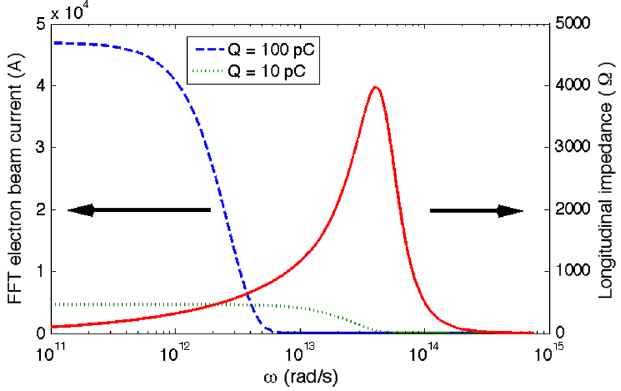
FIG. 20. Spectral distribution of a 750 A Gaussian electron bunch (dashed) and the resistive wall imped- ance per unit length for a g ¼ 100 (cid:1) m aluminum waveguide (solid).